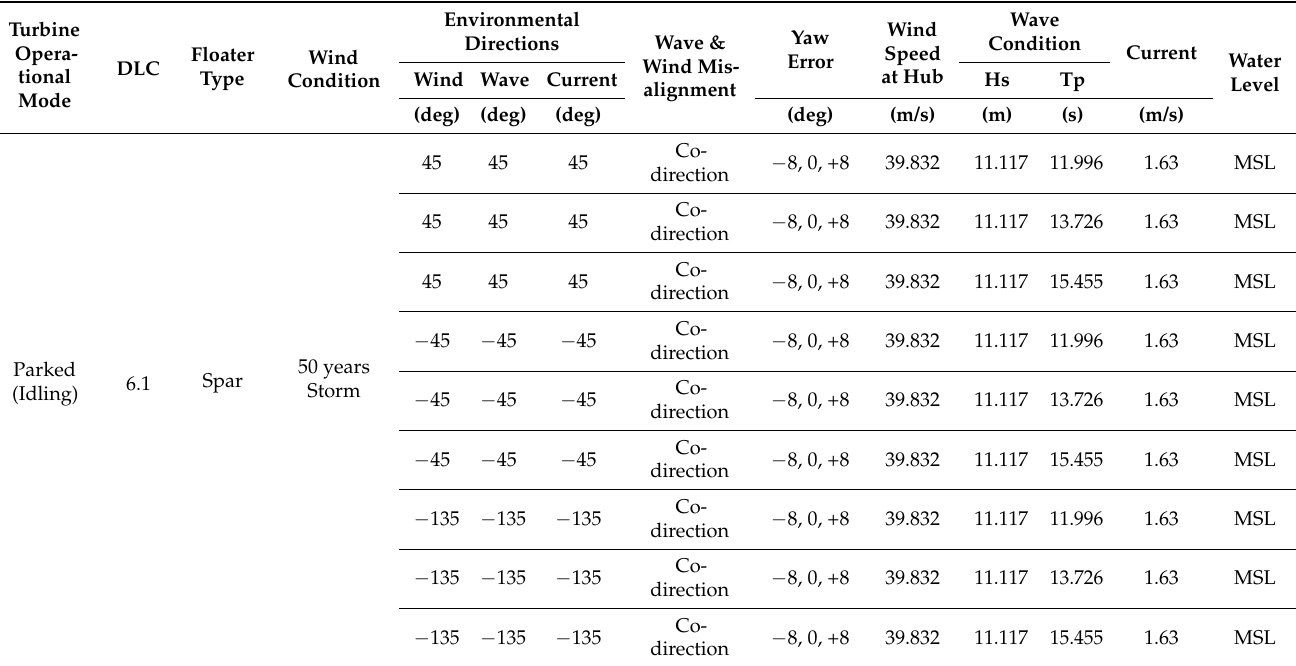
Table 6. Simulation configuration for DLC